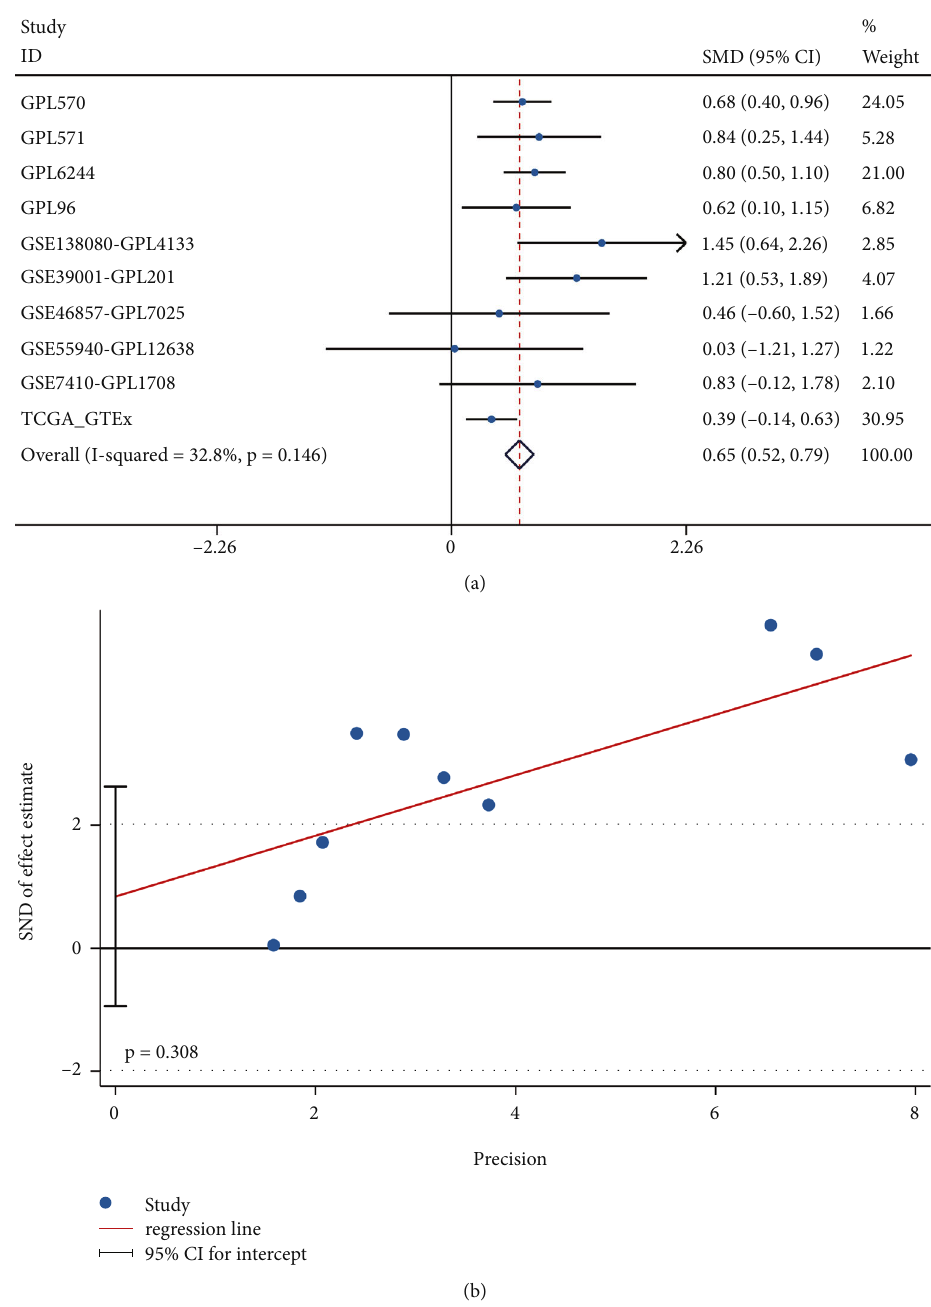
Figure 5: Pooled standard mean di ff erence (SMD) of (a) C1QB mRNA expression between the cervical cancer group and the non-tumor group and (b) Egger ’ s test for publication